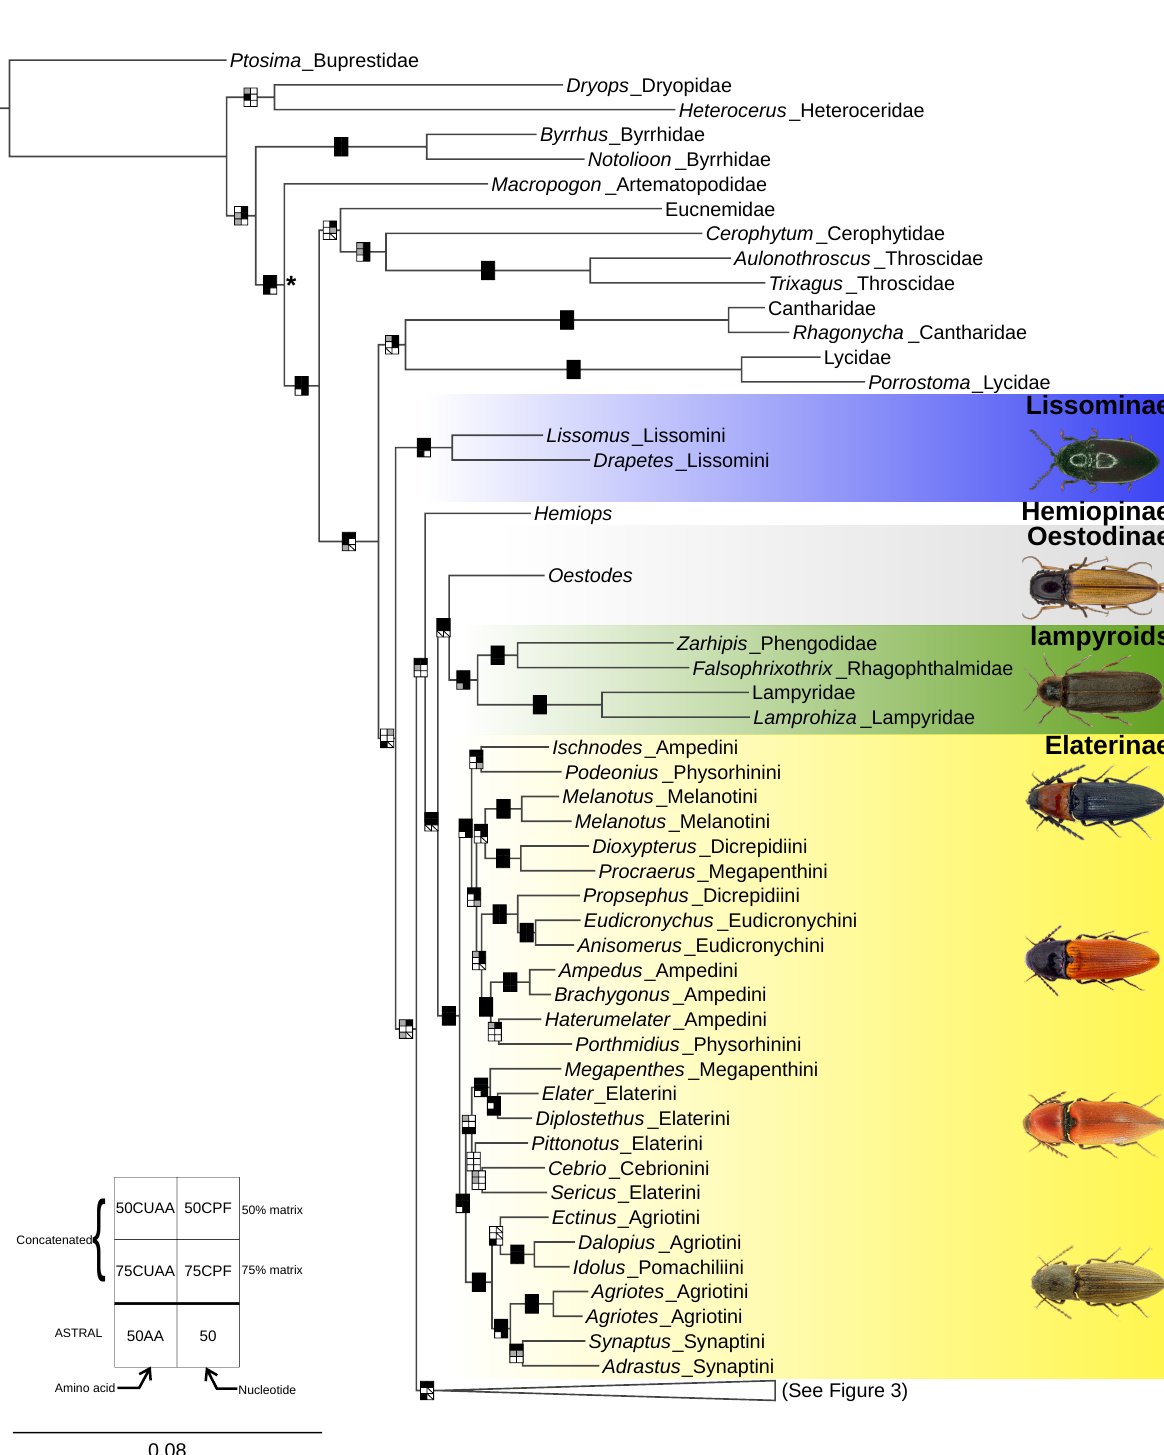
Figure 2. Phylogeny of the Elateroidea inferred from unpartitioned maximum-likelihood analysis of the 50% completeness amino acid matrix (50CUAA—958 loci). An asterisk (*) indicates the root of Elateroidea. Node boxes correspond to individual analyses, as shown in lower-left key and are shaded according to support: black—strong; gray—weak; white—unsupported; slash—strong support for an alternate topology. Beetle images from top to bottom: Lissominae ( Lissomus sp.), Oestodinae ( Oestodes tenuicollis (Randall, 1838)), Lampyridae ( Lampyris noctiluca Linnaeus, 1767), Elaterinae ( Ischnodes sanguinicollis (Panzer, 1793), Ampedus sanguineus (Linnaeus, 1758), Elater ferrugineus Linnaeus, 1758, Agriotes lineatus (Linnaeus, 1767)). Images of Elaterinae are from www.elateridae.com with permission (accessed on 8 January